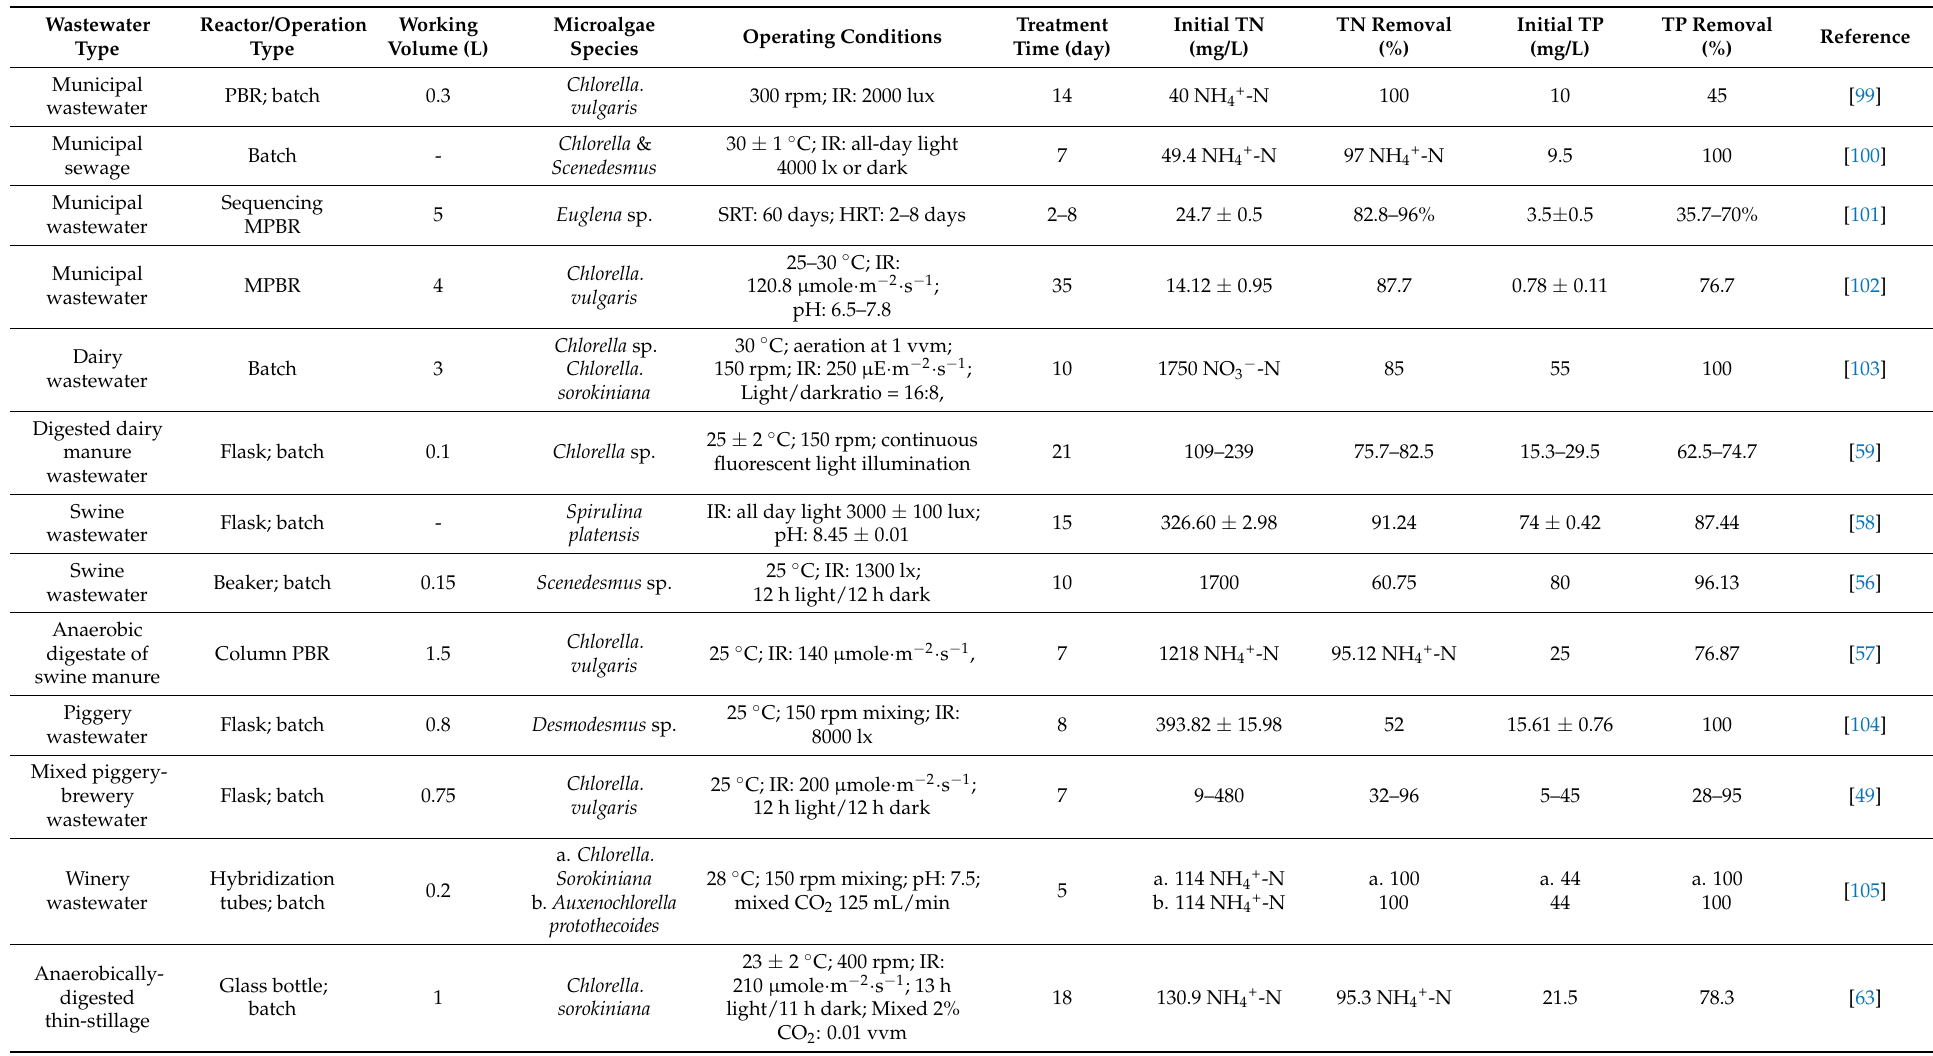
Table 4. The applications and performances of a variety of microalgae-based systems within the years